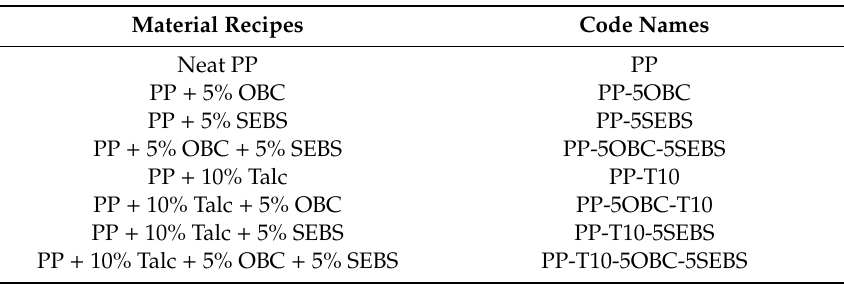
Figure 5. Used screw profile. The main hopper is represented by the down-looking arrows on the right side of the screw, the dye is on the left. The other arrows indicate the two side feeders (not used in this study). Table 5. Produced recipes and related code names.